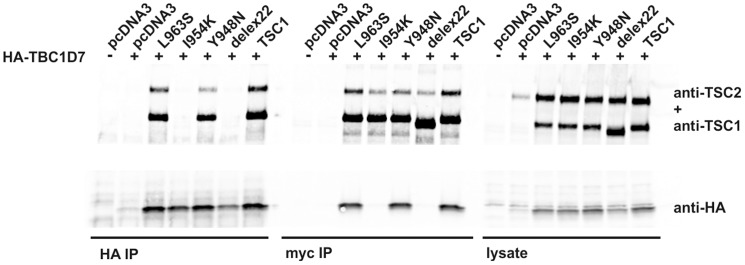
Functional assessment of the effect of the TSC1 Y948N, I954K and L963S variants on the TSC1-TSC2-TBC1D7 interaction.The TSC1 Y948N, I954K and L963S variants were coexpressed with TSC2 in transfected HEK 293T cells. TSC1-TSC2-TBC1D7 complexes were isolated by immunoprecipitation. Immunoblot showing expression of the TSC1 variants (anti-myc), TSC2 (anti-TSC2) and TBC1D7 (anti-HA) in the lysates of the transfected cells (right panels) and in anti-myc (myc IP; central panels) and anti-HA (HA-IP; left panels) immunoprecipitates. TBC1D7 was not detected in the TSC1-I954K or TSC1delex22 immunoprecipitates while TSC1-I954K and TSC1delex22 were not detected in the HA-TBC1D7 immunoprecipitates.